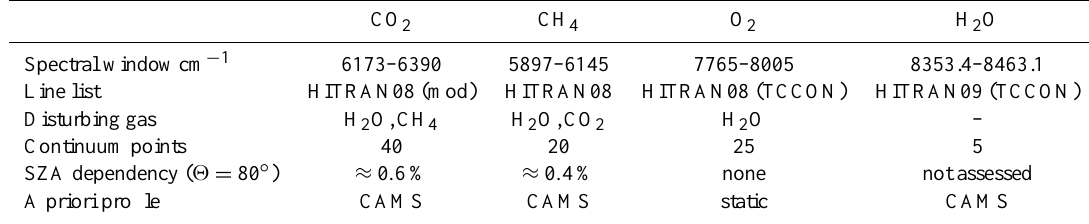
Table 2. List of key retrieval parameters. The line lists are altered from the original HITRAN line lists where “mod” indicates a modification suggested by Lamouroux et al. (2010) to take line mixing effects into account. Likewise “TCCON” indicates a modification suggested by Wunch et al.